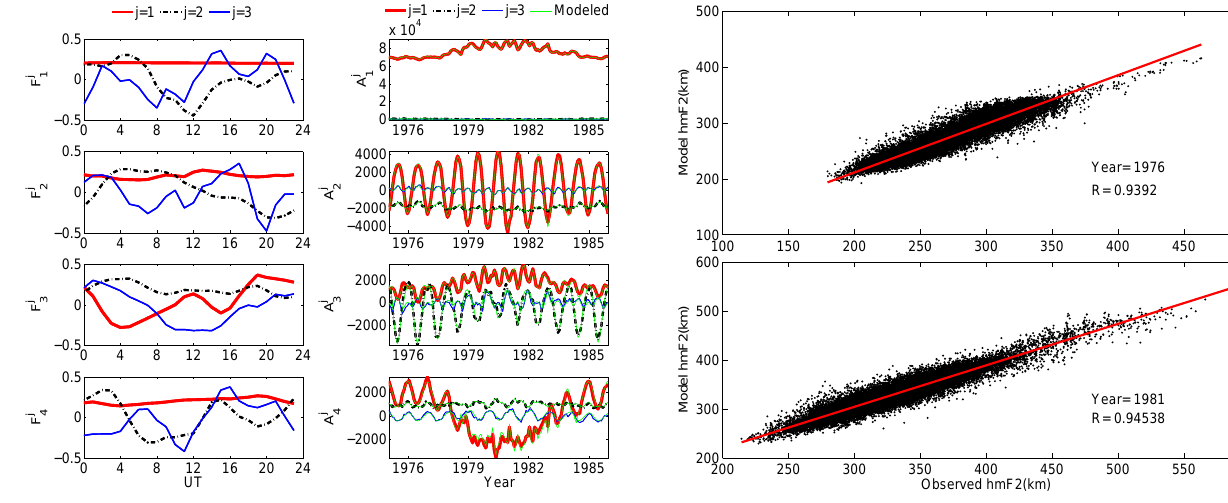
Fig. 6. Scatter plots of model value versus observational data of hm